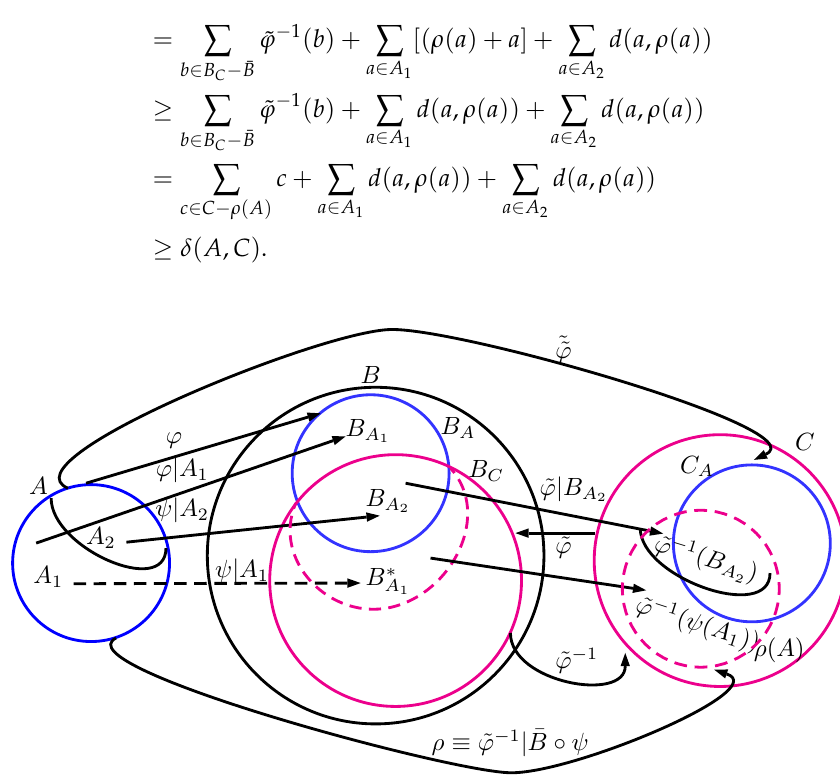
Figure 2. Triangle Inequality for ( 1,3,1 )